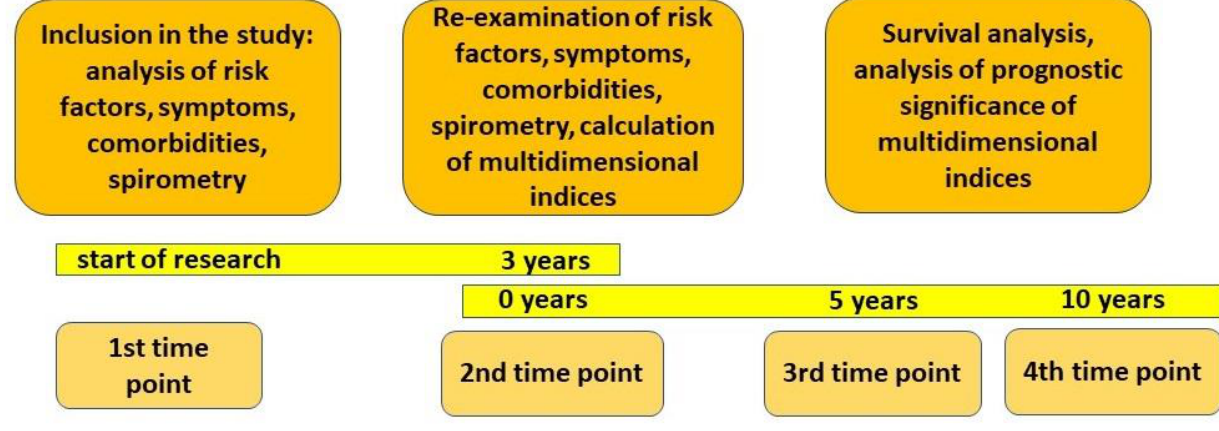
Figure 1. Scheme of the study design.